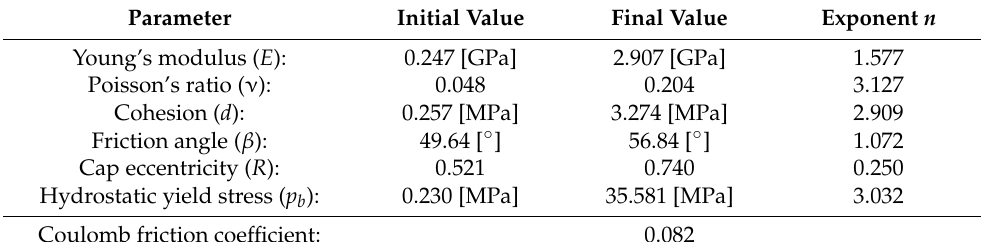
Table 3. Parameters assessed through inverse analysis procedure.